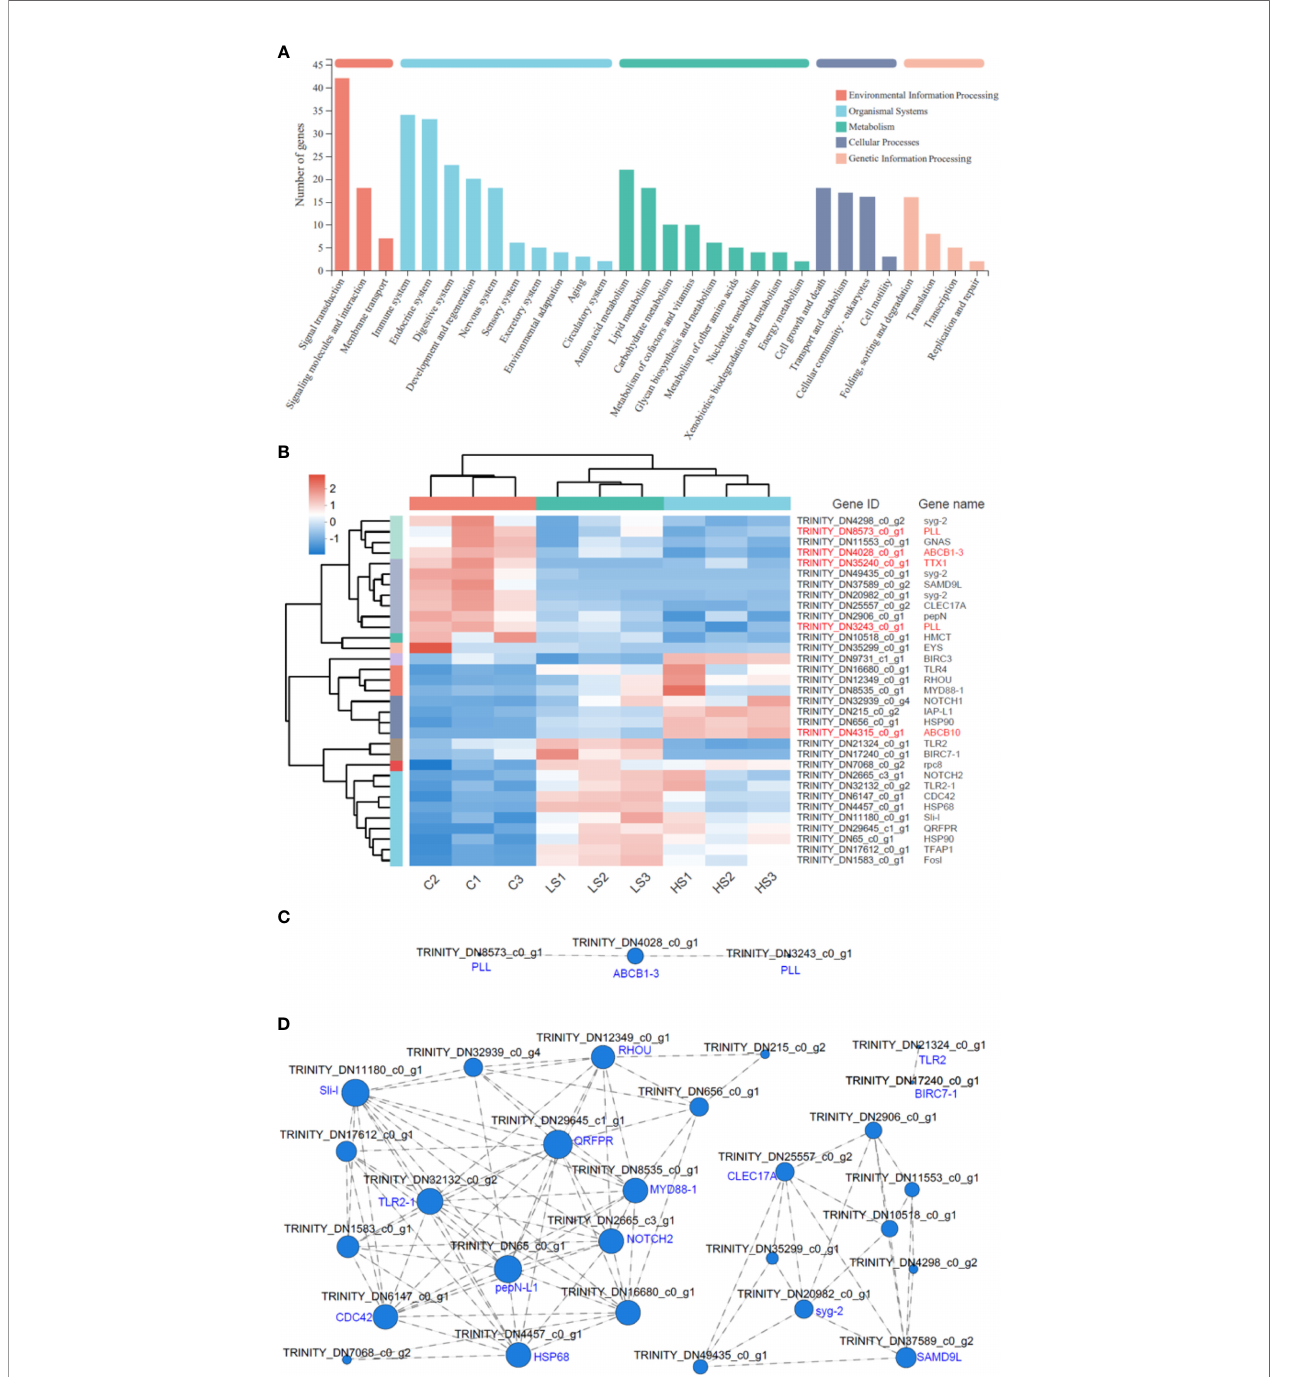
FIGURE 6 | Clustering heat map analysis and the correlation network for expression pattern of genes in membrane transport and the immune system. (A) KEGG functional annotation of DEGs shared by C vs. LS and C vs. HS groups. (B) Expression pattern clustering heat map analysis of genes in membrane transport and the immune system (the red words show the genes involved in membrane transport). (C) Correlation network for expression of genes in membrane transport. (D) Correlation network for expression of genes in the immune system. In (C) and (D) , the larger the gene node, the more genes that have expression correlation with the